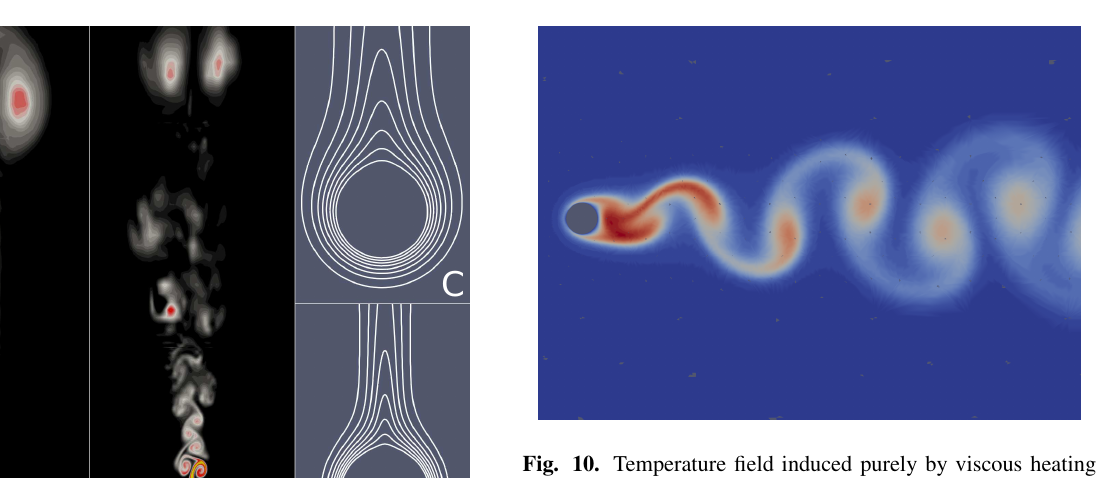
Fig. 10. Temperature field induced purely by viscous heating = T + term (Re = 121 . 8, T + ). Maximal variation of this normal- ∞ W ized temperature is 3 . 8 × 10 − 6